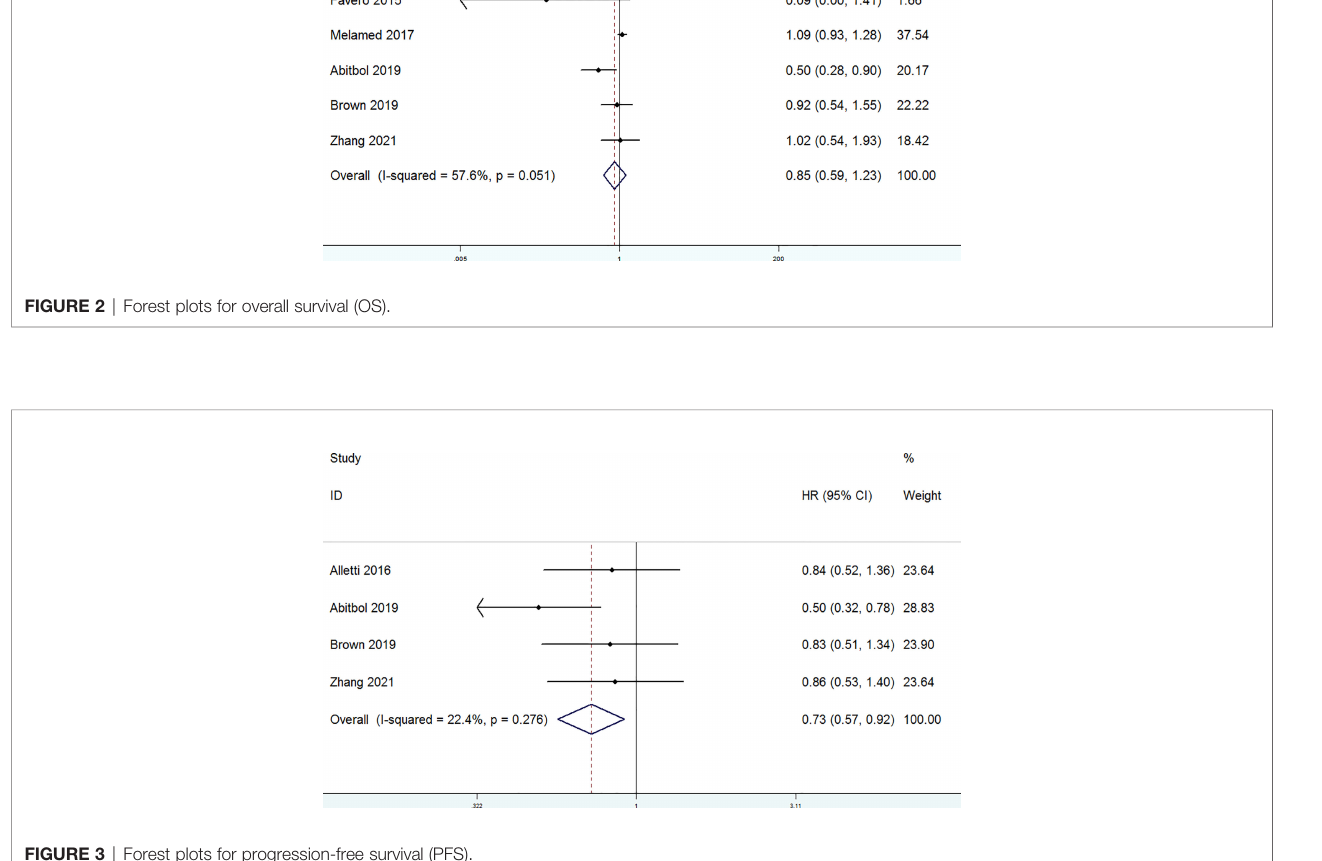
FIGURE 3 | Forest plots for progression-free survival (PFS).